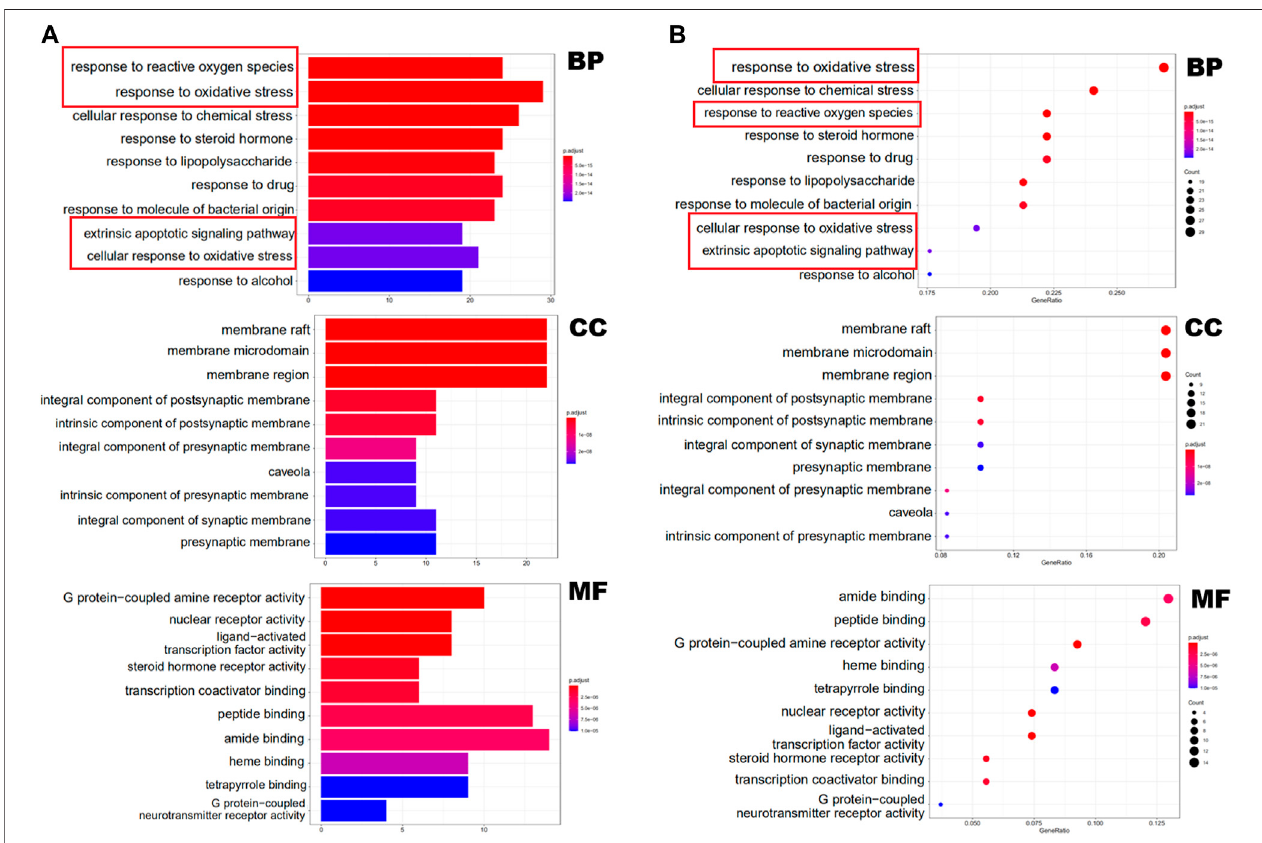
FIGURE 2 | GO functional enrichment analysis represented in bar chart (A) and bubble diagram (B) .